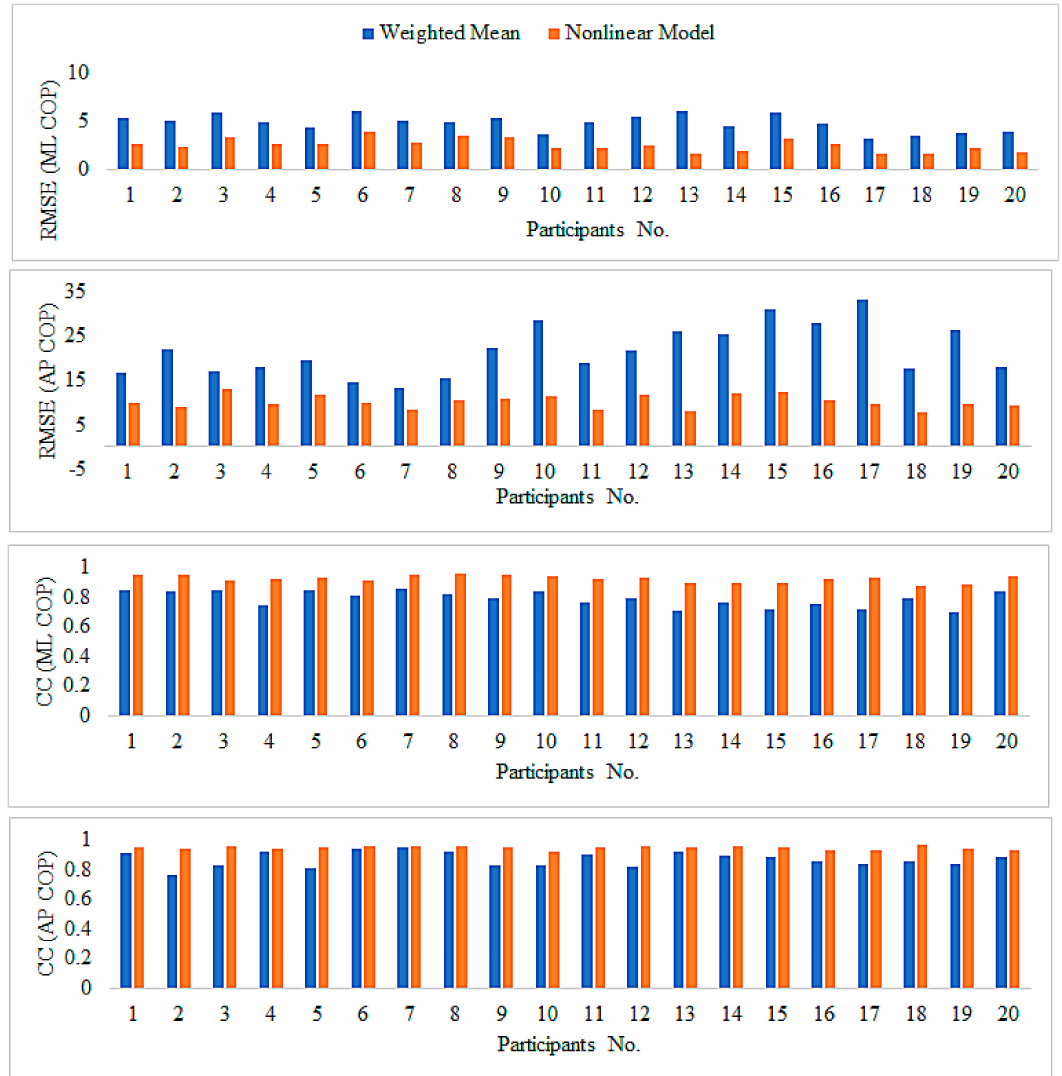
Figure 7. Comparisons of the RMSE and CC between the nonlinear model and the weighted mean